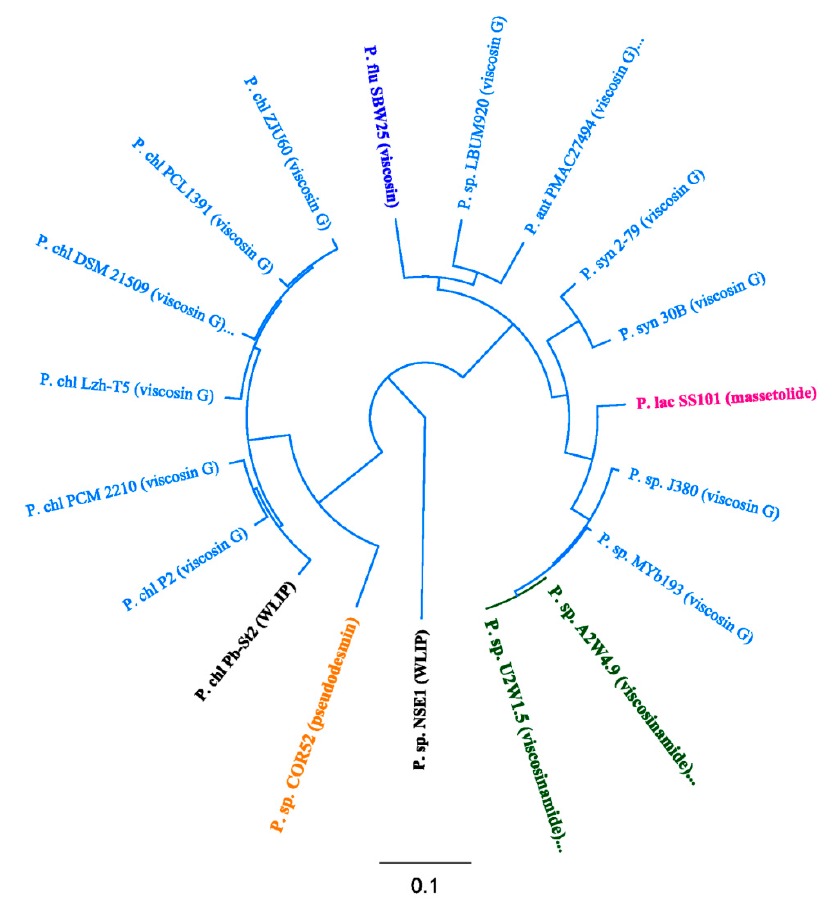
Figure 3. Phylogenetic analyses of the non-ribosomal peptide synthetases (NRPSs) encoded by pseudodesmin and viscosinamide BGCs strains and by selected BGCs of the Viscosin group. The cladogram of a neighbor joining tree was inferred from the alignment of collinearly concatenated NRPS sequences for producers of pseudodesmin ( Pseudomonas sp. COR52), viscosinamide ( Pseudomonas sp. A2W4.9, Pseudomonas sp. U2W1.5), White Line-Inducing Principle (WLIP)